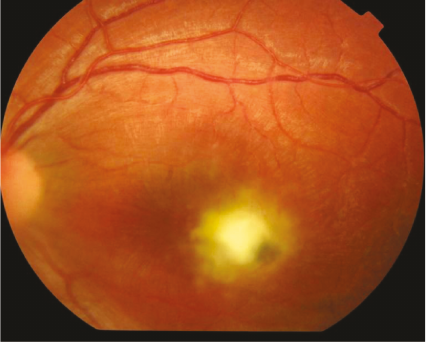
Figure 1: Group I (pretreatment).